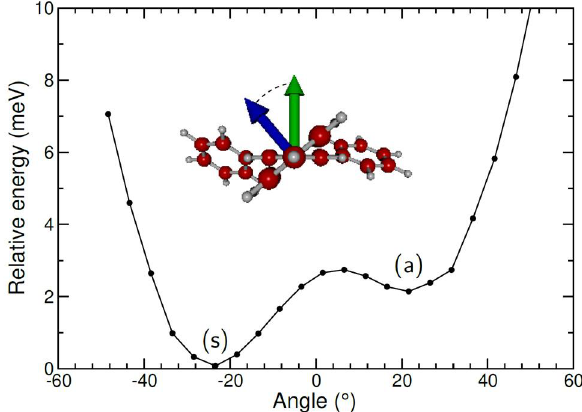
Figure 6. Calculated relative energies for the pathway between the two isomers of TPB + , as obtained by rotating the asymmetric phenyl ring around its axis to the central ring.